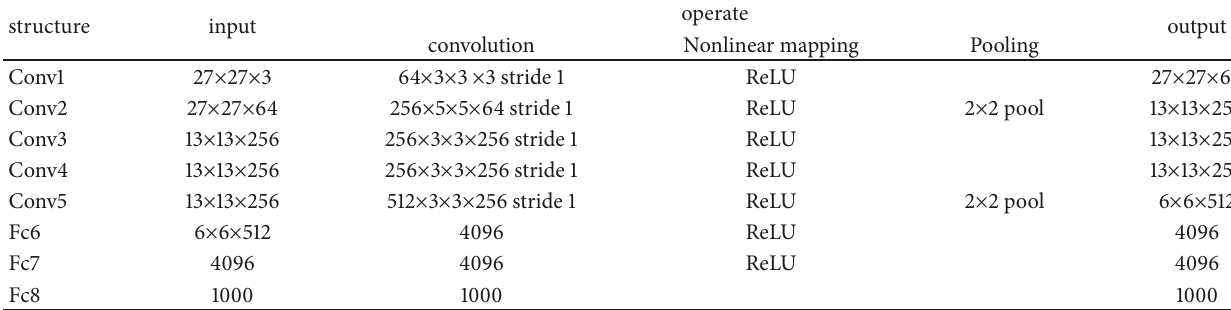
Table 1: Network structure of